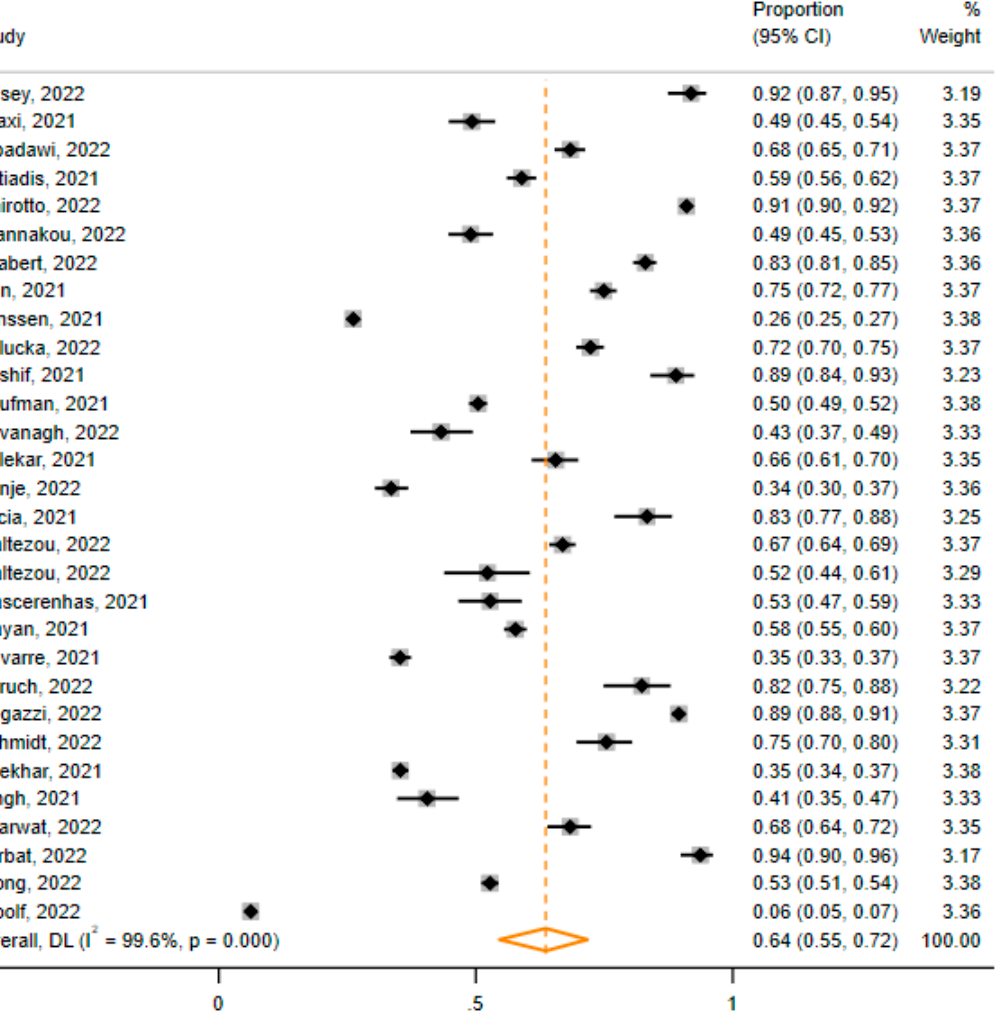
Figure 5. Results of the meta-analysis. The pooled proportion (orange rhombus) of HCWs’ ac- ceptance of mandatory COVID-19 vaccines for HCWs was 64% (95% CI: 55%, 72%) [32,36,37,40,43– of mandatory COVID-19 vaccines for HCWs was 64% (95% CI: 55%, 72%) 46,48,69].